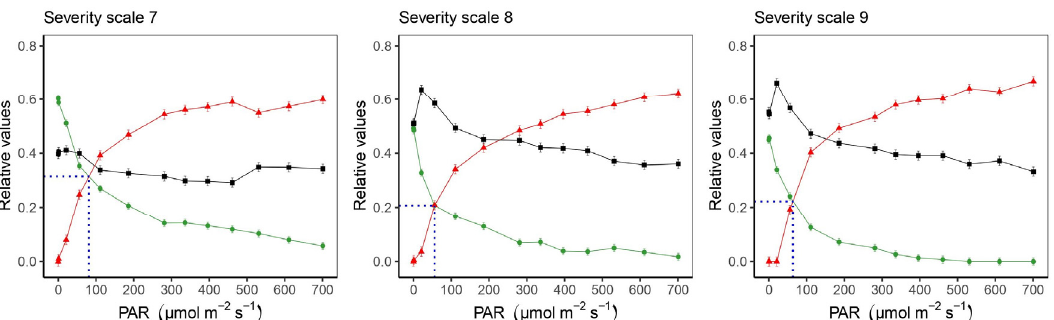
Figure 5. Effective quantum yield in photosystem II [Y(II)]; quantum yield of regulated energy dis-